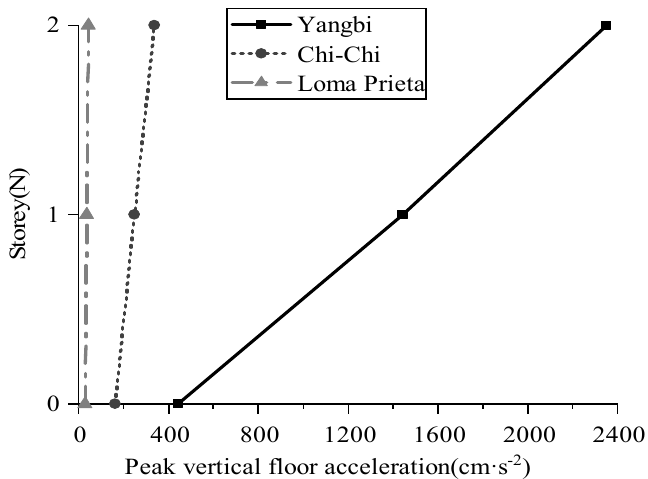
Figure 9. Variation of vertical peak floor acceleration of structure under three ground